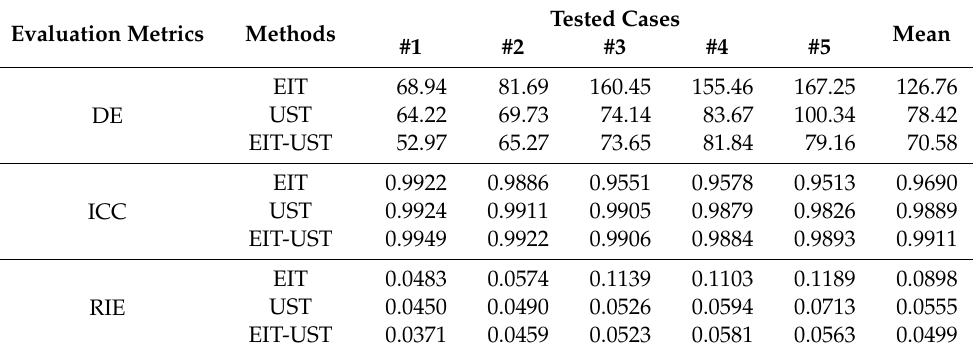
Table 4. Comparison of image reconstruction